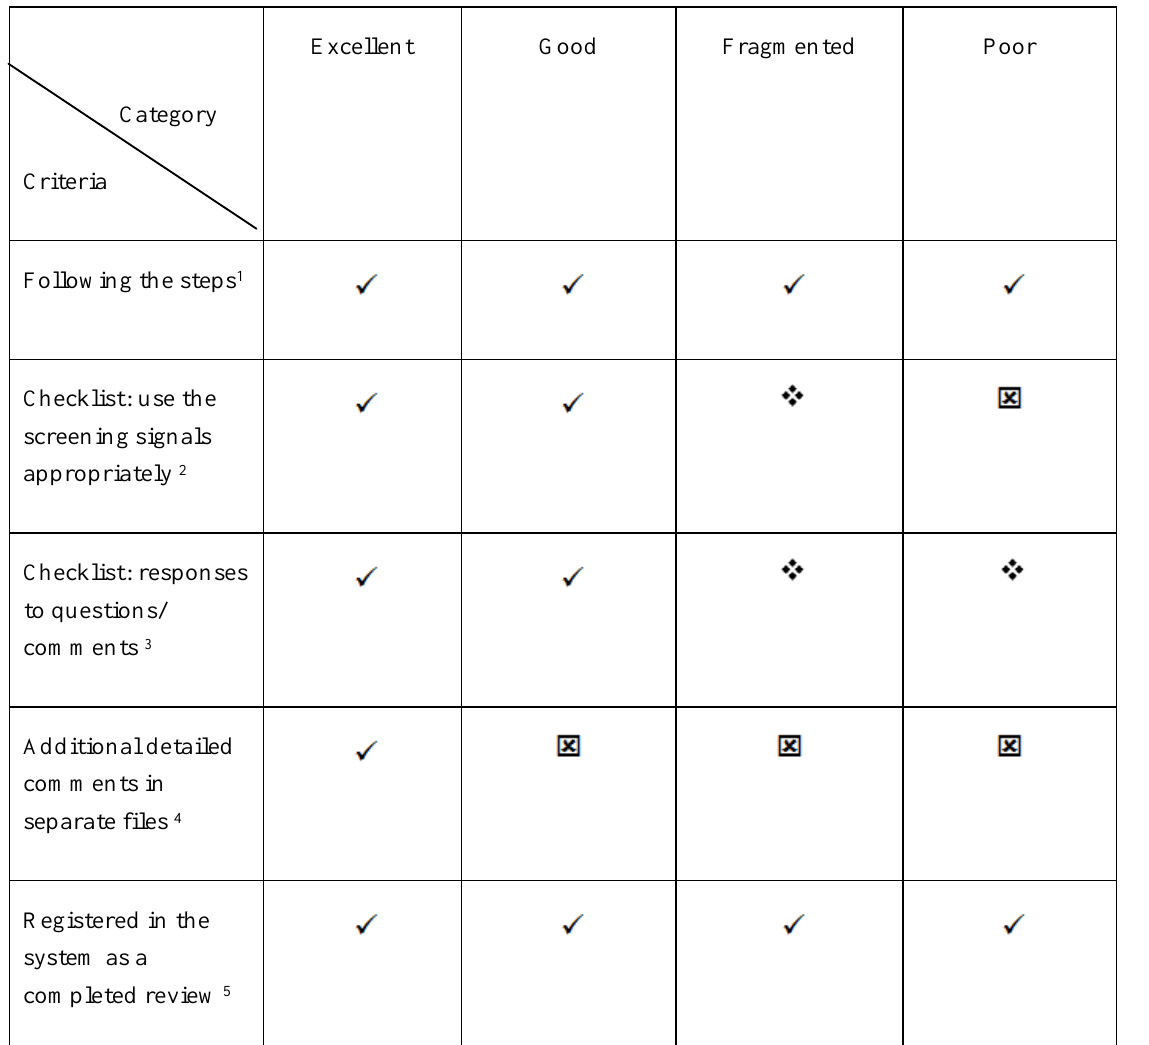
Peer Review Quality Categories and the Defining